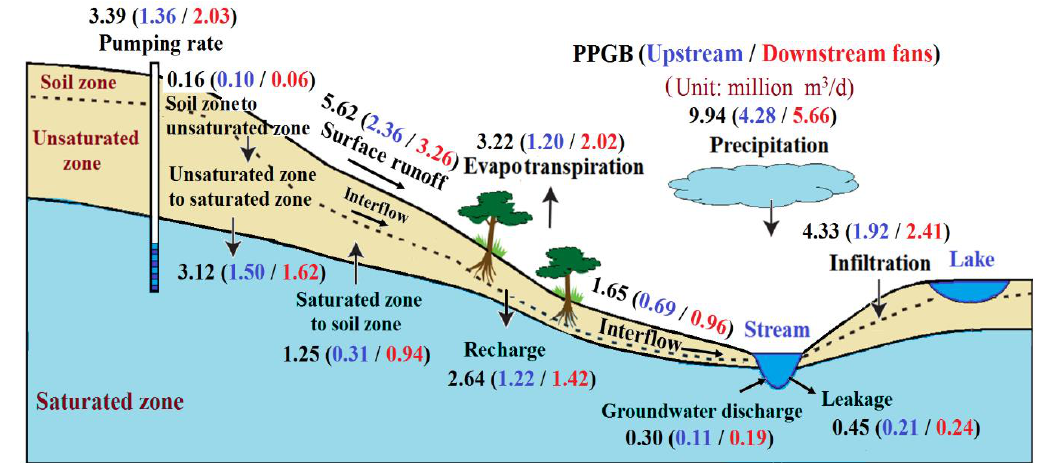
Figure 14. The summary of volumetric flow rates for the water cycle components in the entire PPGB, upstream fan, and downstream fan areas. Note that the blue and red colors represent the flow rates for the upstream and downstream fans.